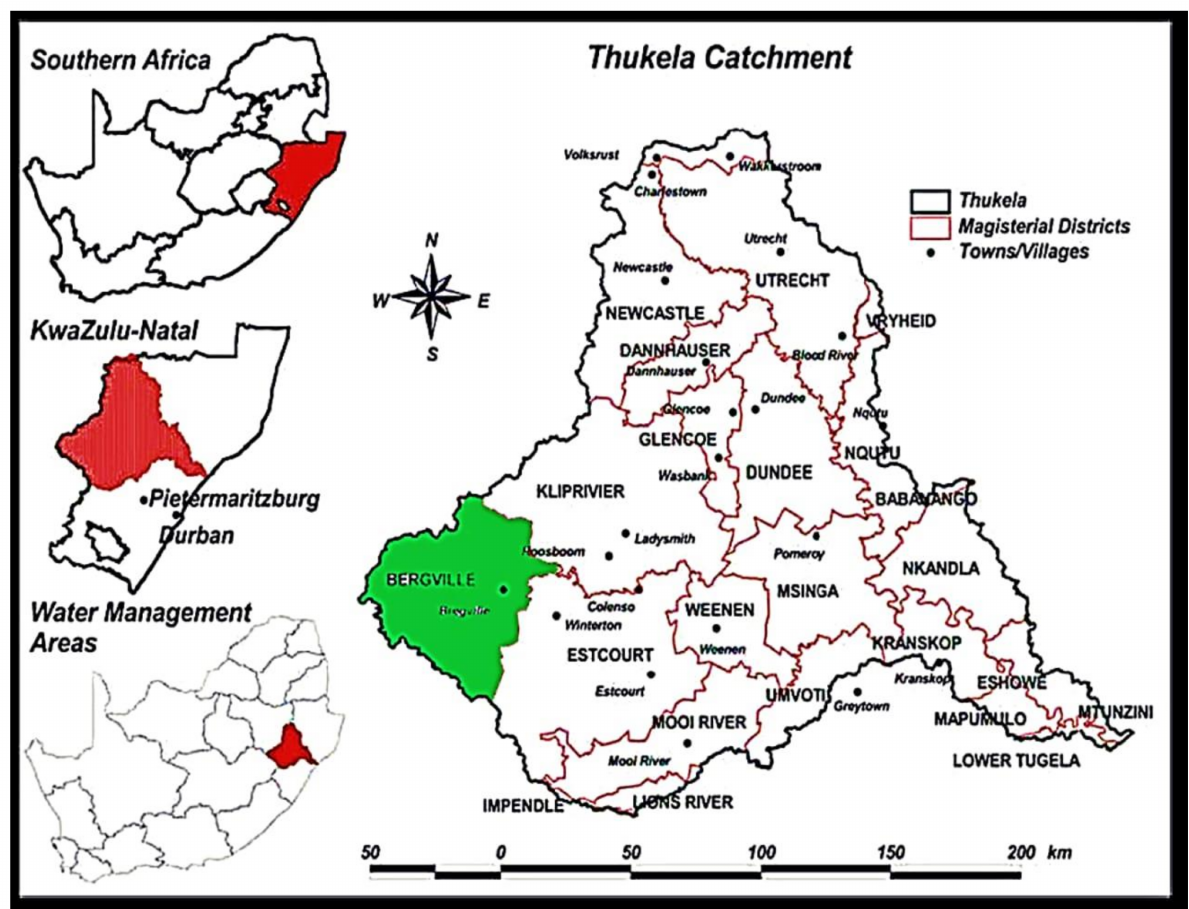
Figure 1. Map showing the Bergville area within uThukela Catchment Region in KwaZulu Natal Province, South